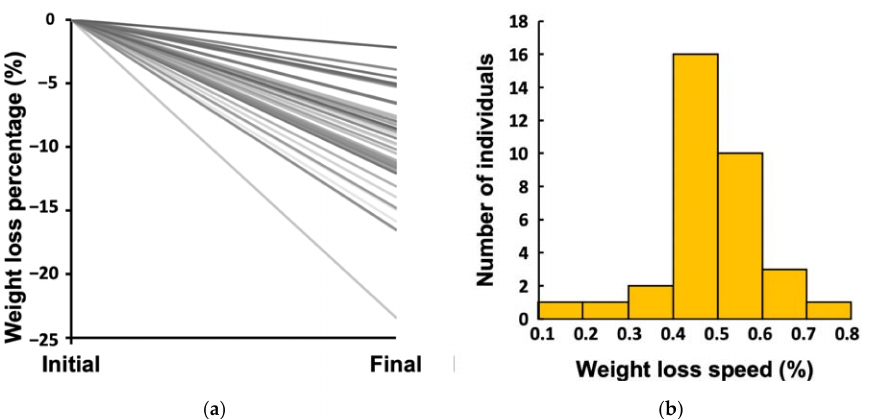
Figure 1. Inter-individual variability in the response to a weight loss treatment: ( a ) total weight loss percentage; ( b ) average weekly weight loss percentage or weight loss speed (WLS) during the treatment.